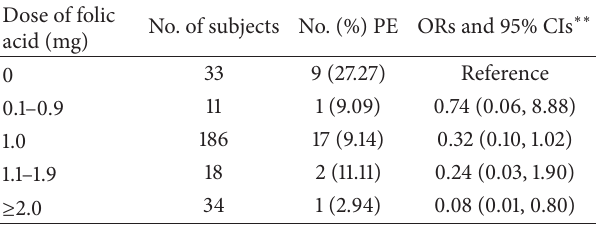
Table 1: Dose-response relationship between folic acid supplemen- tation and PE in high risk ∗ women, OaK birth cohort study,